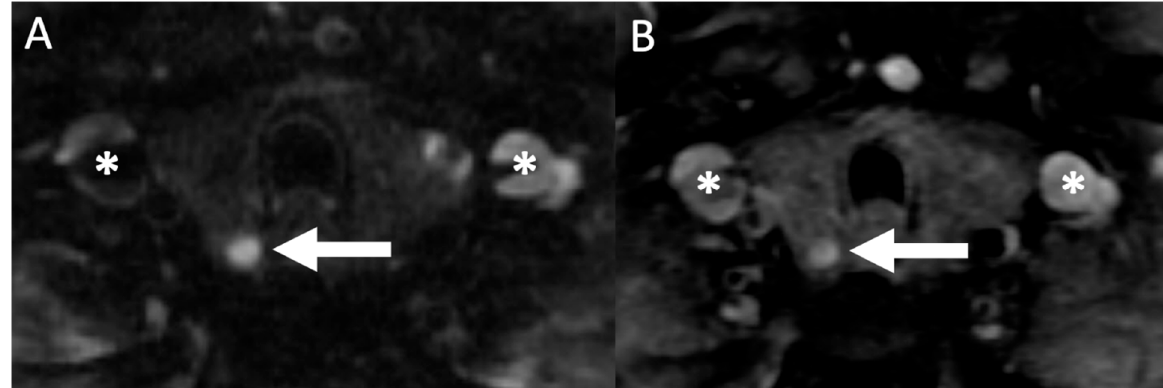
Figure 7. Magnetic resonance imaging (MRI): 71-year-old woman with hypercalcemia. Axial T2 weighted imaging ( A ) showing a hyperintense (bright) nodule posterior to the right thyroid lobe (white arrow) with subsequent axial ( B ) gadolinium contrast enhanced T1 weighted imaging showing an enhancing lesion (white arrow), subsequently resected confirming the presence of parathyroid adenoma on histopathology. Asterisks (*) denote the location of the bilateral jugular veins.